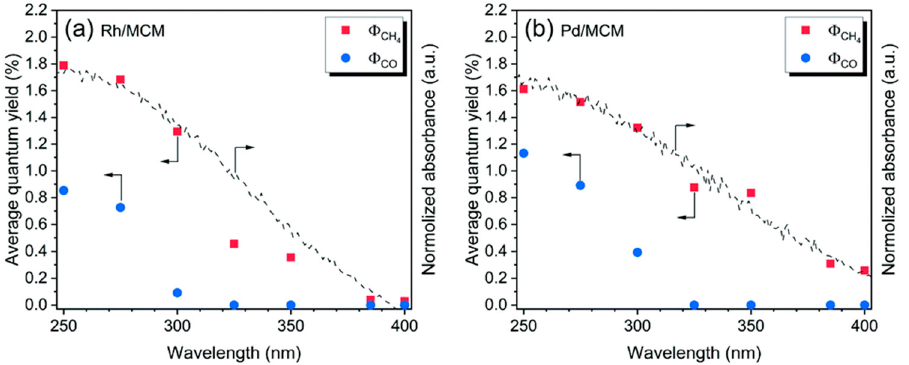
Figure 52. Action spectra of ( a ) Rh/MCM at 423 K and ( b ) Pd/MCM at 523 K in the wavelength range from 250 to 400 nm. Reproduced from [71] with permission from The Royal Society of Chemistry.